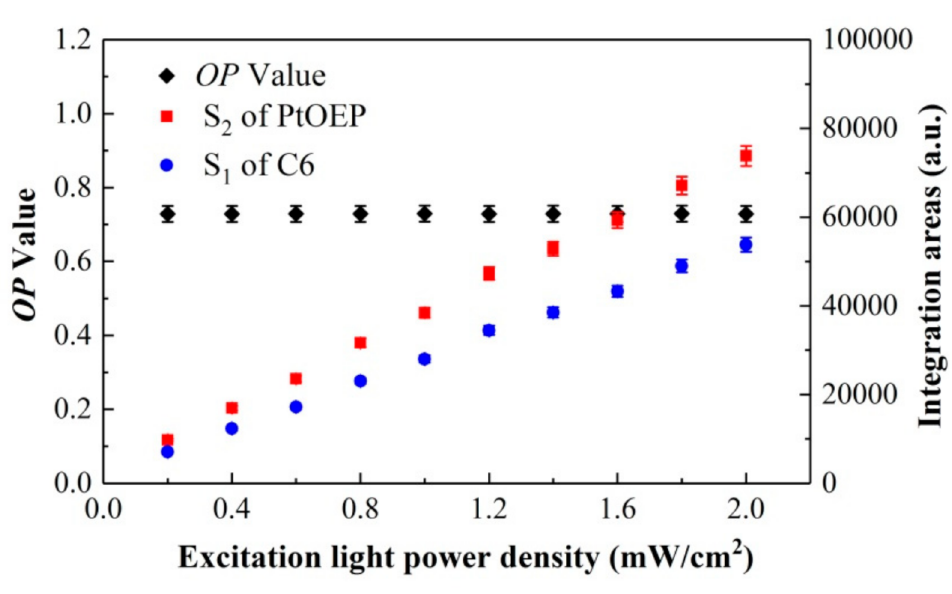
Figure 5. Variations in OP , S 2 of PtOEP, and S 1 of C6 versus excitation light power